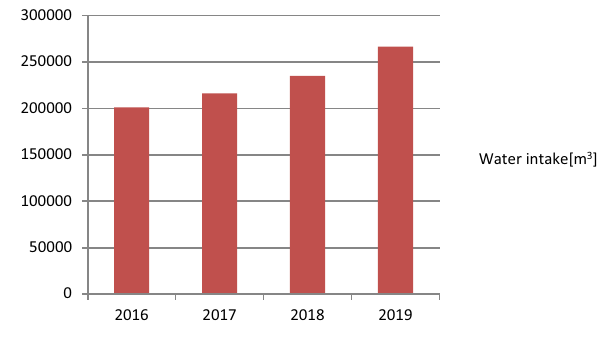
Fig. 1 Summary of water intake in 2016–2019